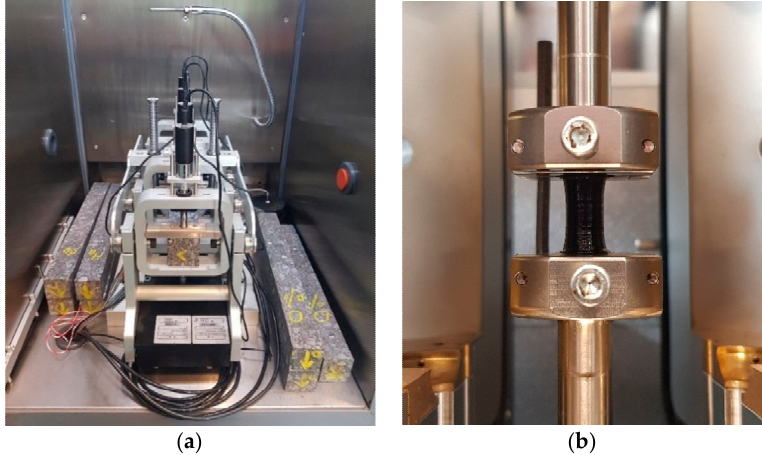
Figure 2. Four-point bending (4PB) testing setup for the asphalt mixtures ( a ) and clamping of the bituminous mortar inside the dynamic shear rheometer (DSR) temperature chamber ( b ).